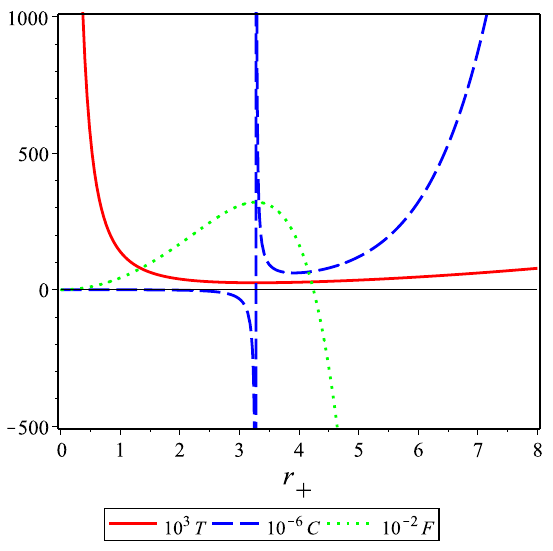
Figure 6 . Behavior of C , T and F with respect to r + for k = 1 , n = 5 , x = 2 and α = 1 for “ − ” sign branch.